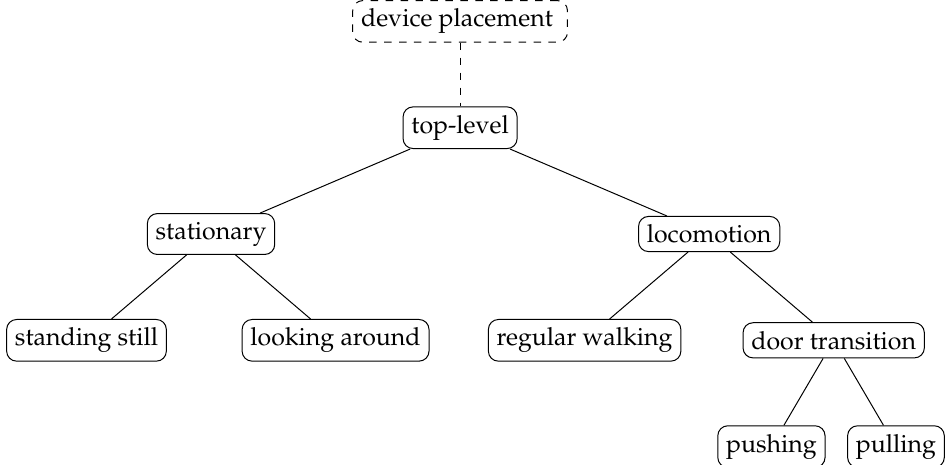
Figure 3. The hierarchical classification approach consisting of multiple binary classifiers arranged in a tree